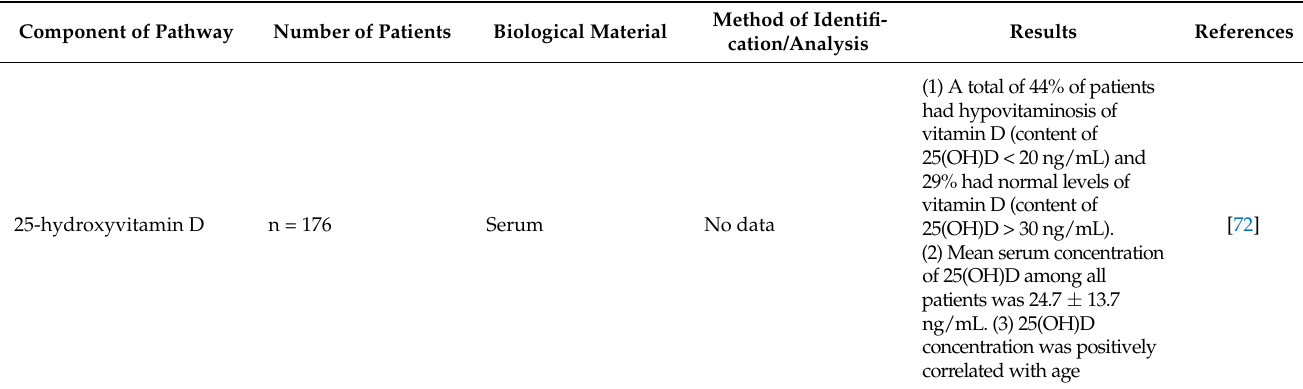
Table 4. Characteristics of the vitamin D metabolic pathway components in rotator cuff arthroplasty. Component of